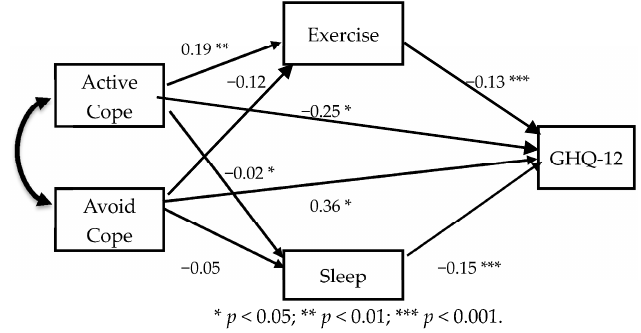
Figure 1. Model of mediation path analysis with coping styles for the effect between health habits and psychological distress.